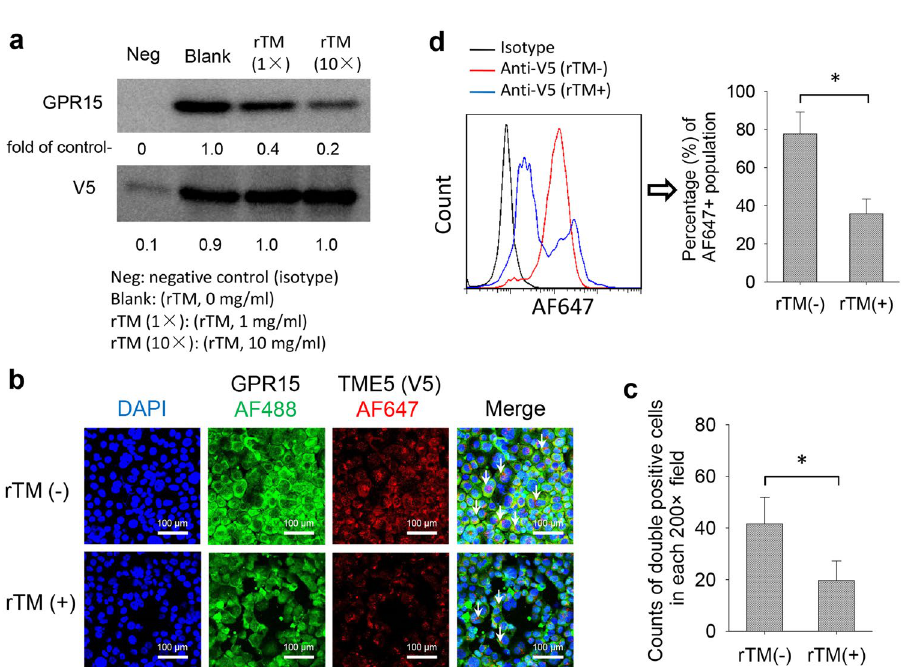
Figure 1. TME5 interacts with GPR15. ( a ) Immunoprecipitation. Membrane proteins isolated from HUVECs were incubated with V5-tagged TME5 (100 μ g/ml) in the presence of gradient doses of rTM (0 mg/ml, 1 mg/ ml, 10 mg/ml), followed by immunoprecipitation with anti-V5 antibody. Mouse derived isotype antibody was used as negative control. The precipitated proteins were subjected to Western blot analysis to detect the indicated proteins. Figure represents one of the three independent experiments. Relative intensities of bands were analyzed with ImageJ software. ( b–d ) EA.hy926 cells were pre-incubated with either rTM or control diluent followed by incubation with V5-tagged TME5 overnight. ( b ) Immunocytochemistry. Cells were fixed on slide glasses by Autosmear. The fixed cells were stained with anti-GPR15 and V5 antibodies followed by staining with Alexa Fluor 488- and Alexa Fluor 647-conjugated second antibodies. The nuclei were stained with 4 ′ ,6-Diamidino-2-phenylindole dihydrochloride (blue). ( c ) Alexa Fluor 488- and Alexa Fluor 647-double positive cells were indicated by white arrows and were counted on 6 random areas under a microscope. ( d ) Flow cytometric analysis. Cells were incubated with anti-GPR15 and V5 antibodies followed by staining with Alexa Fluor 488- and Alexa Fluor 647-conjugated second antibodies. Cell were analyzed on a flow cytometer. Figure shows percentage of Alexa Fluor 647-positive population gated on Alexa Fluor 488-positive cells (n = 6). rTM, Recombinant human soluble thrombomodulin; TME5, the fifth EGF-like region of